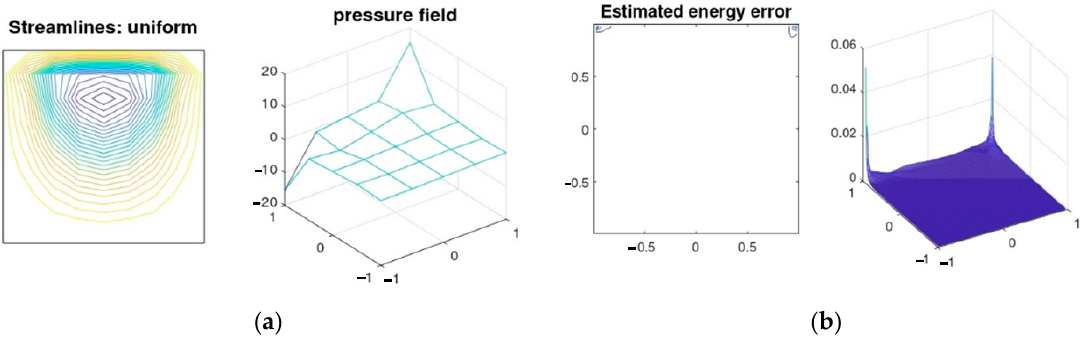
Figure 8. Error associated with a 16 × 16 and a 256 × 256 square grid, Q 2 – Q 1 approximation. ( a ) 16 × 16 elements; ( b ) 256 × 256 elements.